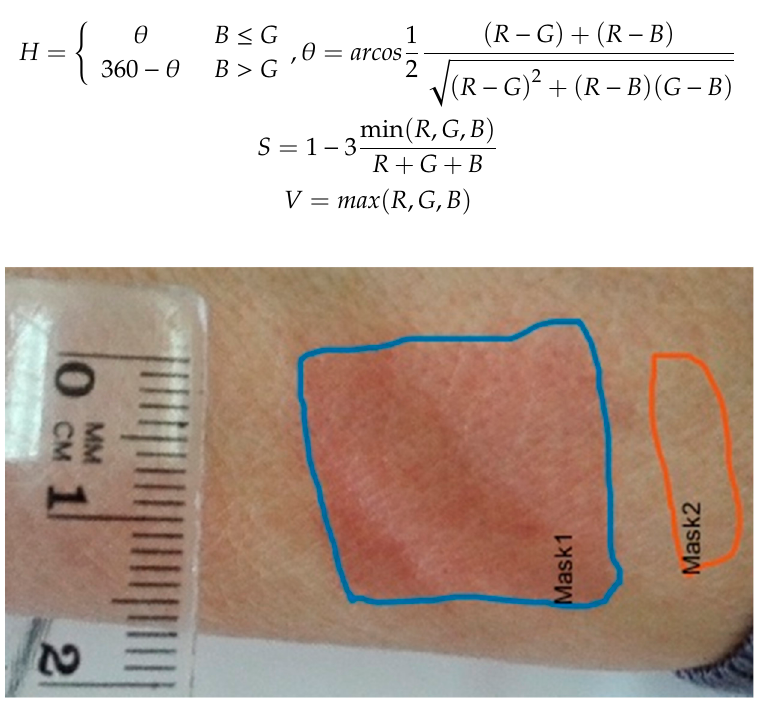
Figure 1. The image of the forearm of a patient from the BD group, dose 0.1 M, measurement